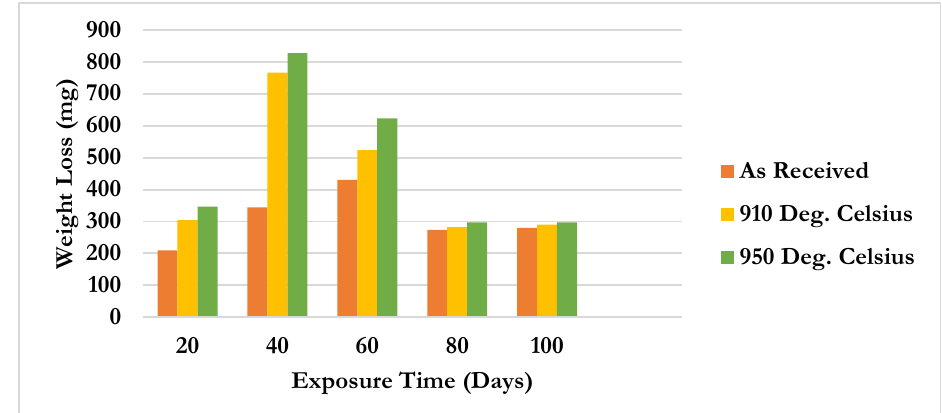
Fig. 3. Weight loss against exposure time for un-welded annealed medium carbon steel.